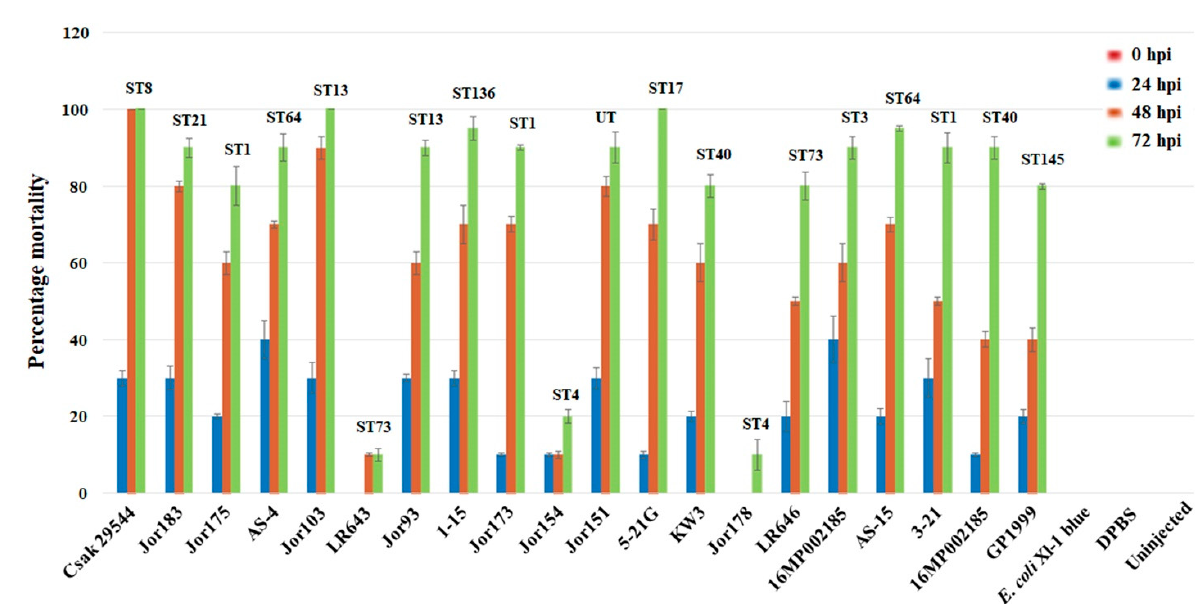
Figure 2. Results of zebrafish embryo infection (ZI) experiments (time course 0–72 hpi (hours post infection)) with plant-origin and malonate-positive C. sakazakii ST64 strains compared to clinical strain ATCC 29544 T (ST8) and E. coli Xl-1 blue as positive and negative control, respectively. DPBS indicates Dubelcco’s phosphate-buffered saline. Jor103 and 5-21G of the 19 C. sakazakii strains killed 100% of the zebrafish embryos in 72 h in a similar manner to C. sakazakii strain ATCC 29544 T . Except for three strains, the other 14 strains killed at least 80% of the zebrafish embryos by 72 hpi. Three plant-associated strains, LR643 [ST73], Jor154 [ST4] and Jor178 [ST4], had mortality less than 20% in this time-period.